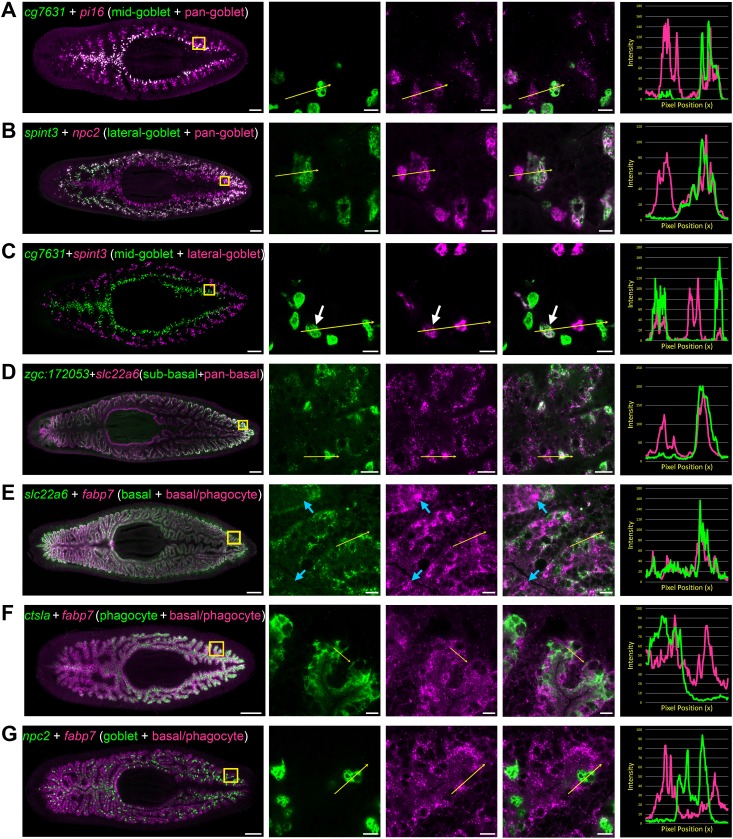
Transcripts expressed by intestinal subpopulations and multiple cell types.(A) Confocal images of cg7631 (green) and pi16 (magenta) in situ hybridization. Left to right, whole animal (yellow box indicates magnified region in right panels), zoomed area in green, magenta, and merge (yellow arrow indicates profile line in right-most panel), and a graph showing pixel intensity in each color from tail to head of the yellow profile arrow. cg7631 is enriched in medial goblet cells, while pi16 is found in all goblet cells. (B) spint3 (green) and npc2 (magenta). spint3 is enriched in the lateral goblet cell population, while npc2 is expressed by all goblet cells. (C) cg7631 (green) and spint3 (magenta). cg7631 is enriched in medial goblet cells; spint3 is enriched in lateral goblet cells. Only rarely do these two markers label the same cell, indicated with a white arrow. (D) zgc:172053 (green) and slc22a6 (magenta). zgc:172053 is enriched in a subset of basal cells, while slc22a6 is more ubiquitously enriched in most basal cells. (E) slc22a6 (green) and fabp7 (magenta). slc22a6 is a basally enriched gene, while fabp7 is expressed by both basal cells and more apical cells (phagocytes). Blue arrows indicate apical gene expression where slc22a6 is absent. (F) ctsla (green) and fabp7 (magenta). ctsla expression is enriched in phagocytes, while fabp7 is found in both phagocytes and basal cells. (G) npc2 (green) and fabp7 (magenta). npc2 is enriched in goblet cells, and overlaps minimally with fabp7 in phagocytes and basal cells. Detailed gene ID information is available in Supplementary file 1 and in Results. Scale bars, whole animals 200 μm; magnified images, 10 µm.